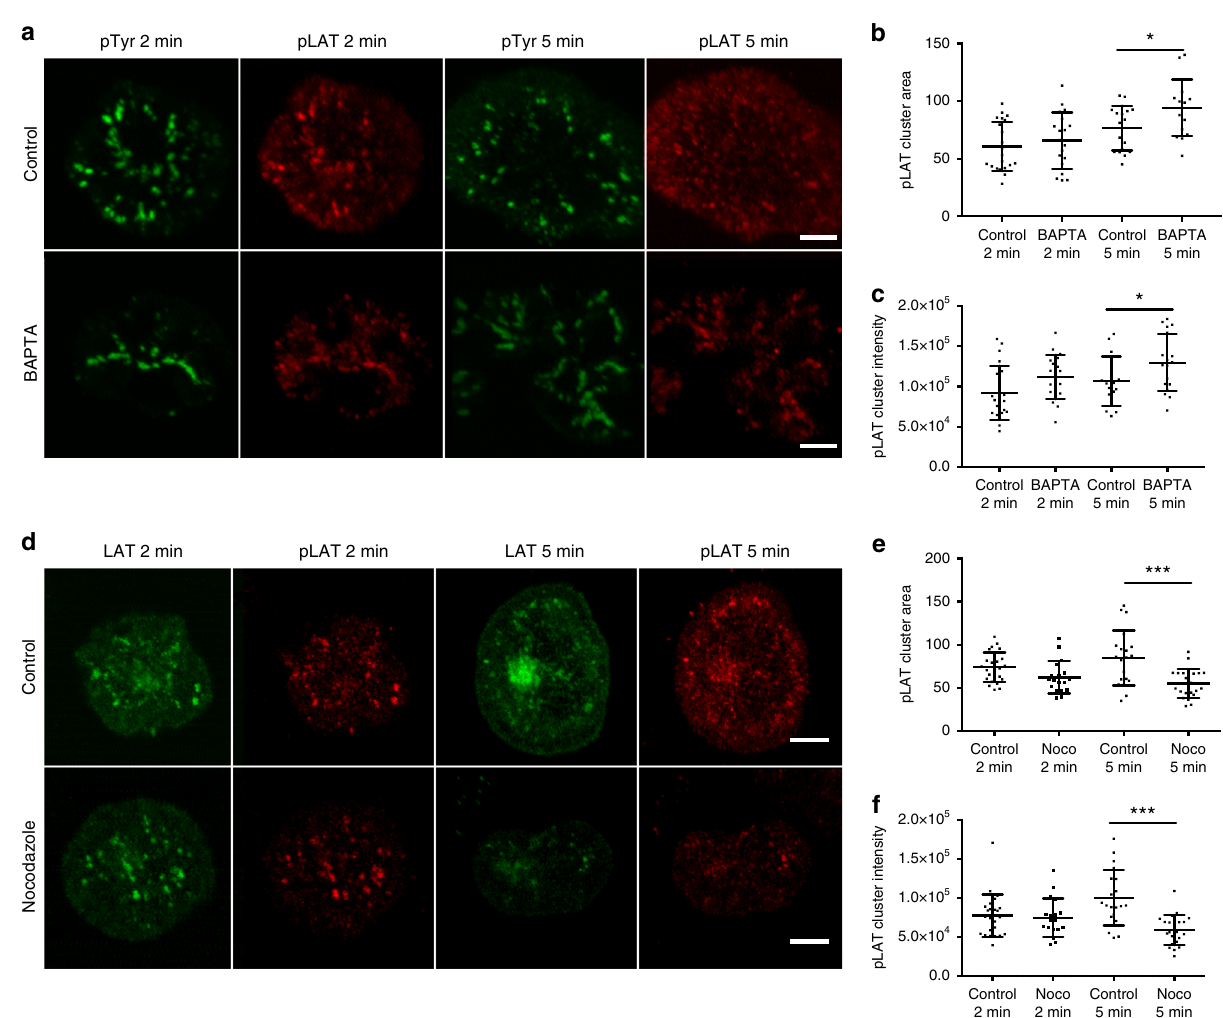
Fig. 1 BAPTA and nocodazole inhibition do not affect LAT microcluster formation. a Jurkat cells were treated with DMSO and dropped onto stimulatory coverslips in a medium containing DMSO (control) or treated with BAPTA and dropped onto stimulatory coverslips in a medium containing EGTA (BAPTA), and fi xed 2 and 5 min after dropping. Cells were then permeabilized and immunostained with pTyr and pLAT. Scale bar equals 2 μ m. b Cluster area and c cluster intensity of pLAT microclusters were quanti fi ed. d Jurkat cells transfected with LAT-ruby were treated with DMSO and dropped onto stimulatory coverslips in a medium containing DMSO (control) or treated with nocodazole and dropped onto coverslips in a medium containing nocodazole (nocodazole) and fi xed 2 and 5 min after dropping. Cells were then permeabilized and immunostained with pLAT. Scale bar equals 2 μ m. e Cluster area and f cluster intensity of pLAT microclusters were quanti fi ed. See also Supplementary